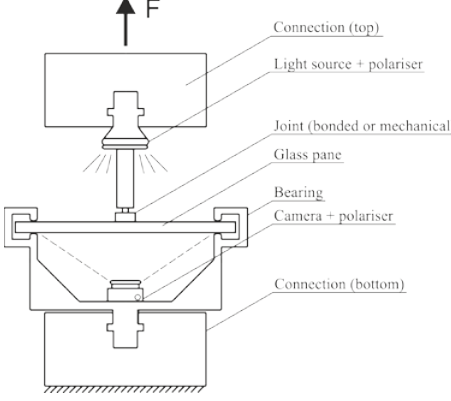
Fig. 7 Concept of the test setup for the load case “tension/